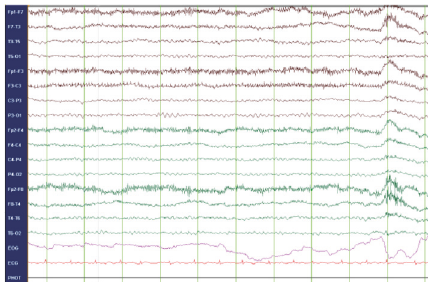
Figure 2: EEG showing global slow cerebral activity without epileptiform